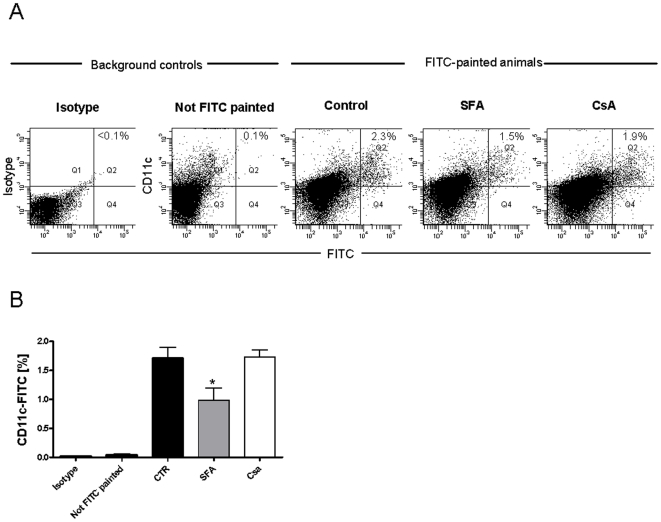
In vivo administration of SFA inhibits migration of FITC-labelled CD11c+ DCs.Mice were injected i.p. with SFA (10 mg/kg/day, 2days), CsA (10 mg/kg/day, 2 days) or vehicle. On day two, abdomen of mice were FITC-painted. The inguinal lymph nodes were removed 24 h later and CD11c+FITC+ migrated cells quantitated by flow cytometry. (A) Dotplot analysis of CD11c+ FITC+ DCs. Numbers indicate percentages of CD11c+FITC+ DCs. (B) Mean (± SEM) numbers of CD11c+ FITC+ DCs in SFA-injected versus vehicle-treated controls. Results are representative for n = 3–5 independent experiments. *p<0.05 versus vehicle.